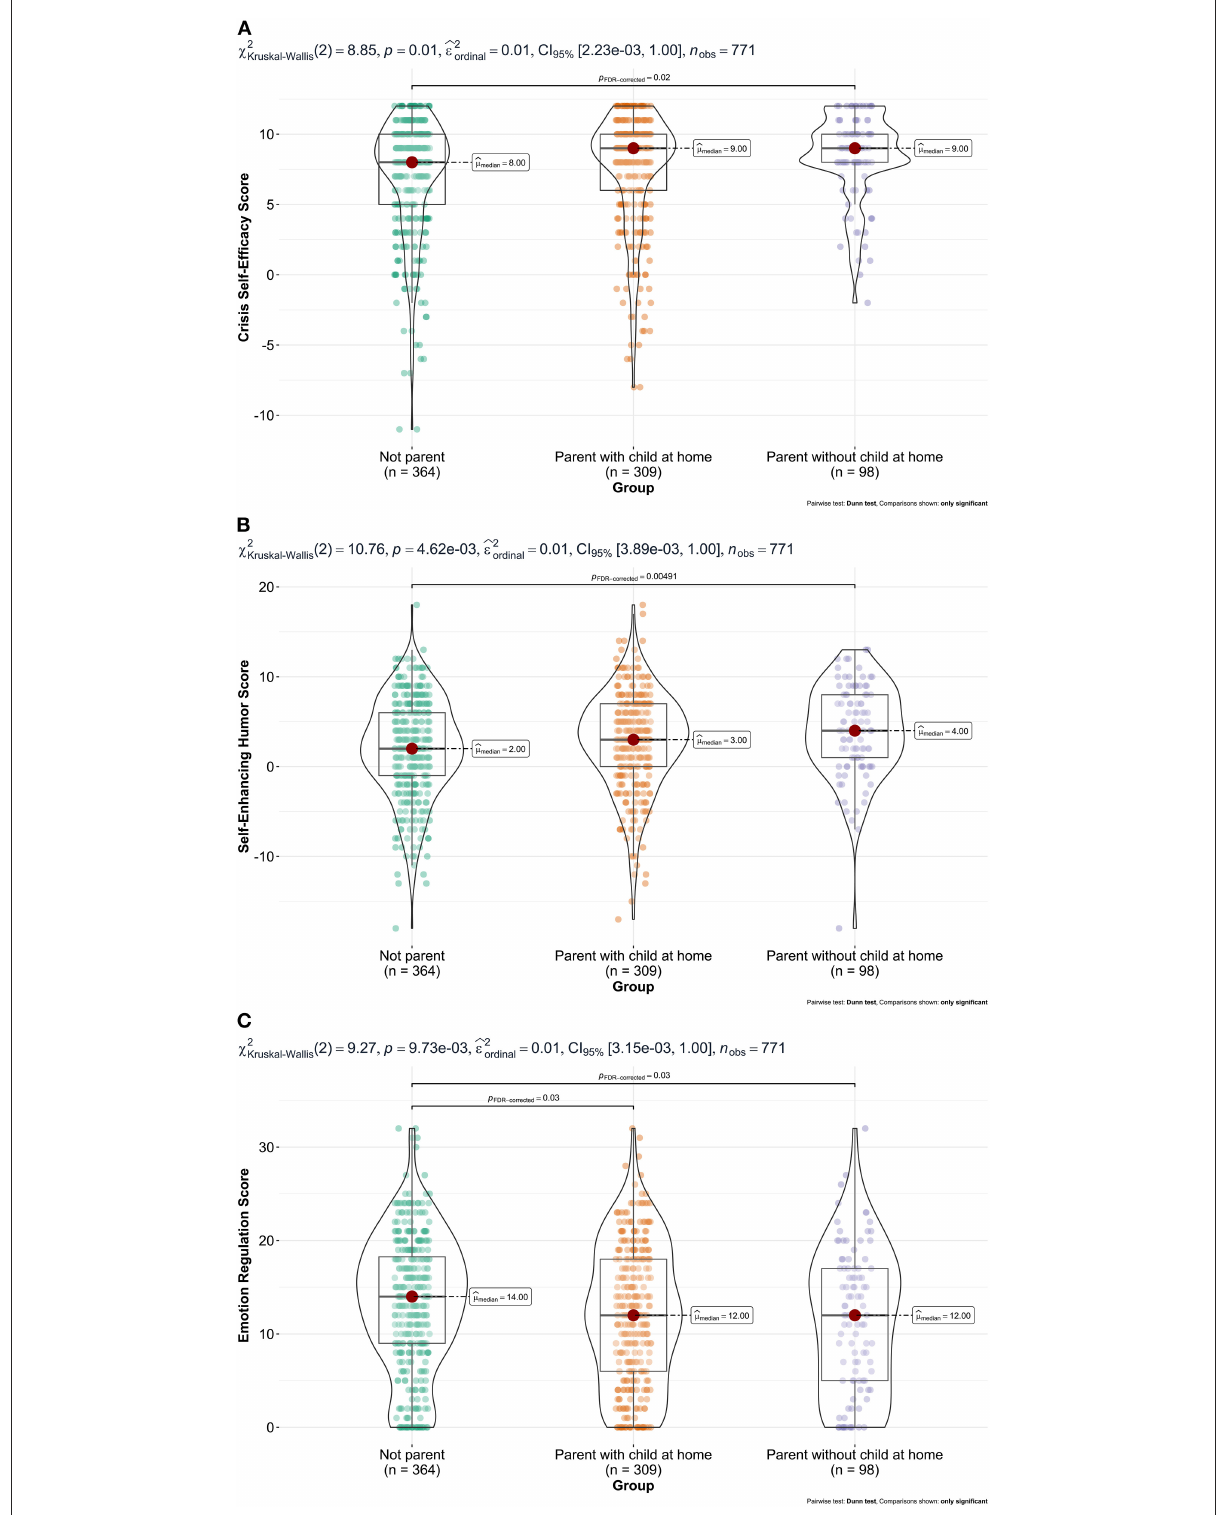
FIGURE1 Group comparisons for (A) crisis self-efficacy, (B) self-enhancing humor, and (C) emotion